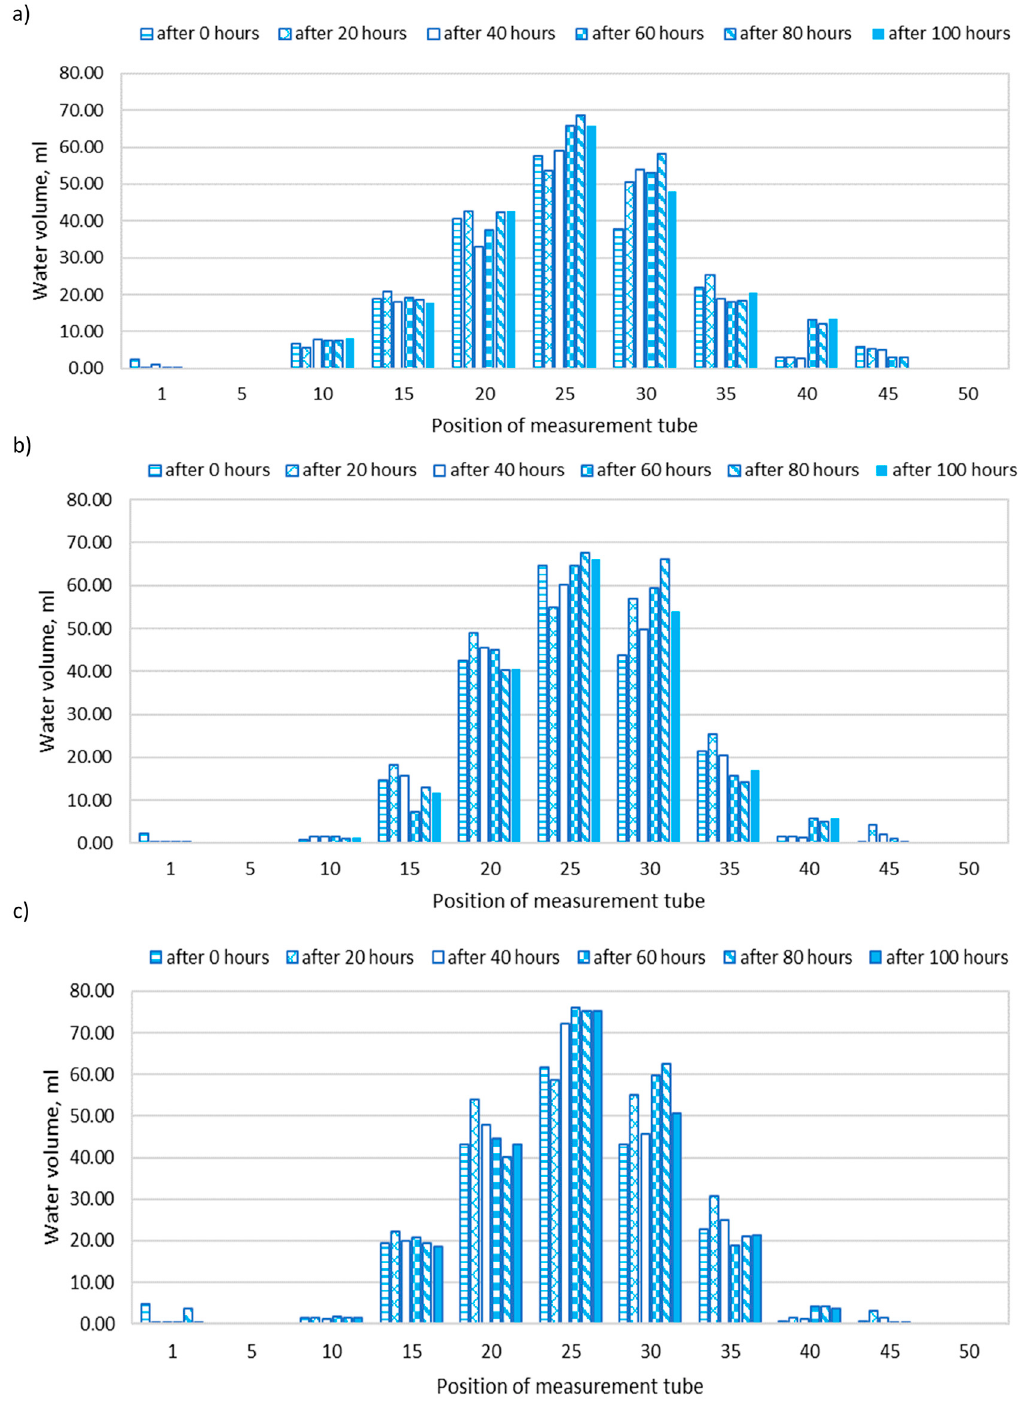
Figure 6. Spray distribution of various nozzles during different wear hours: ( a ) TT, ( b ) TTj60, ( c ) DG. A comparison between the three types nozzles (TT, TTj60, and DG) of the spray dis-